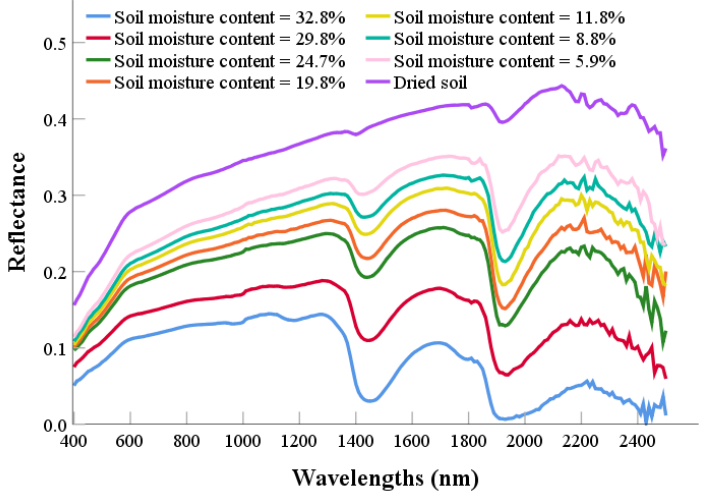
Figure 3. The soil reflectance of gradient moisture content.